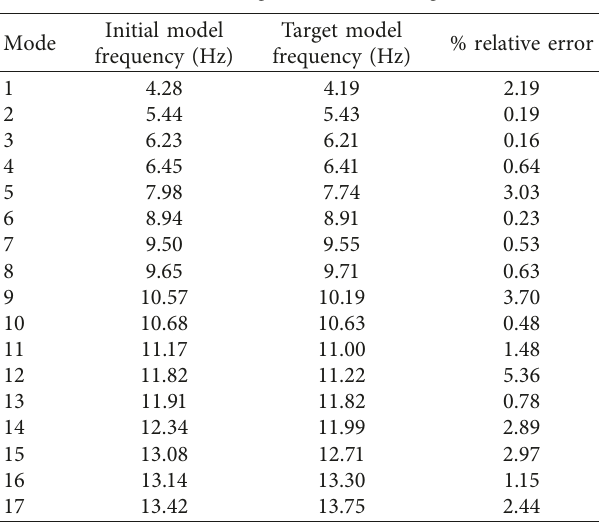
Figure 25: Low and medium fuel locations. Table 15: Fuel configurations for configuration